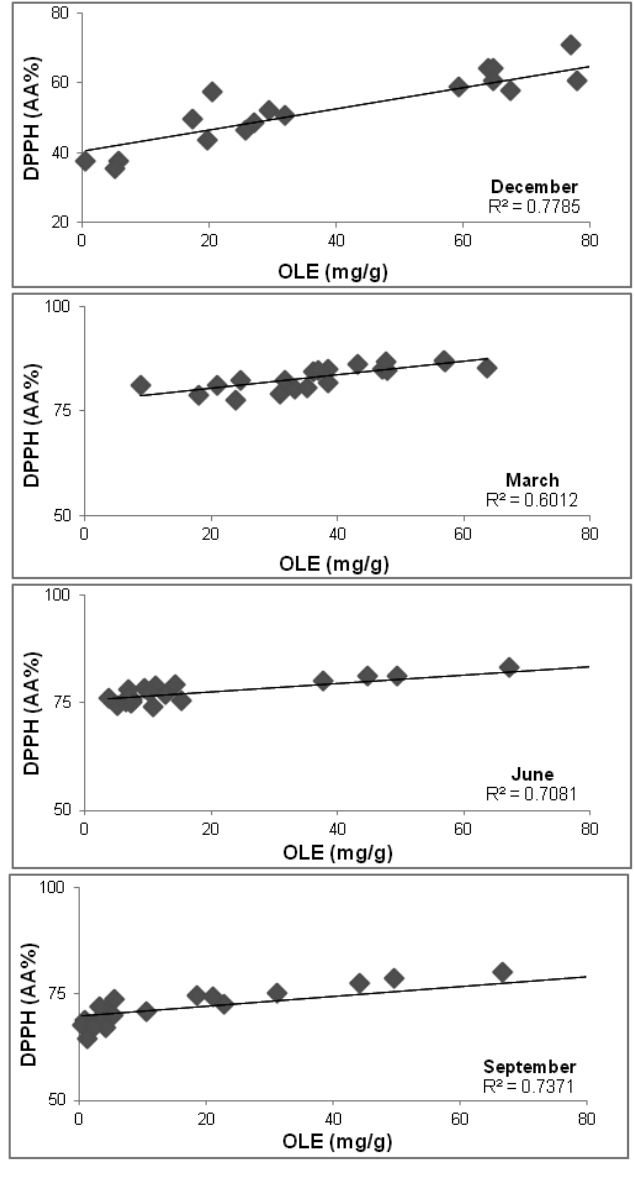
Fig. 7: Correlation plots between oleuropein content (mg/g) and DPPH value (AA%) of olive leaf samples from the considered cultivars harvested in different